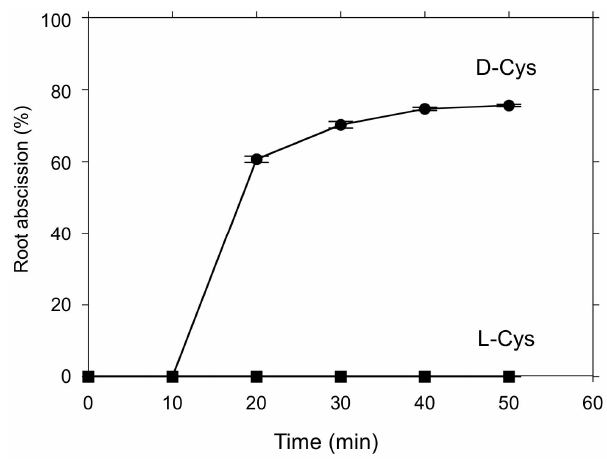
Figure 6. Time course of the D ‐cysteine‐induced root abscission in A. pinnata . 3 mM of either D ‐cysteine ( D ‐Cys) or L ‐cysteine ( L ‐Cys) was added into the culture medium (pH 5.8). Means ± SE ( n = 5).